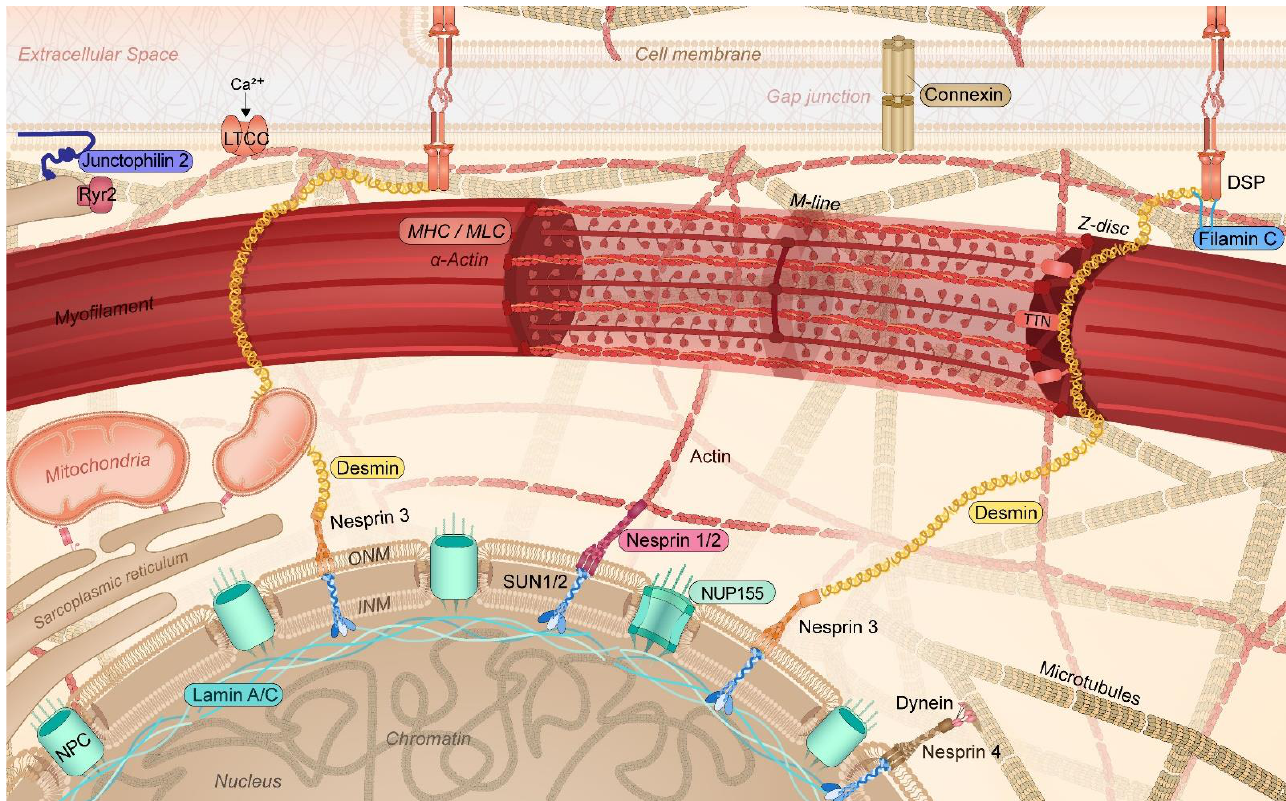
Figure 2. Schematic representation of the specific cytoskeletal protein complexes in cardiomyocytes linked to the onset of AF. Cytoskeletal (-associated) protein variants related to AF are highlighted (colored box). DSP: desmoplakin; INM: inner nuclear membrane; LTCC: L-type calcium channel; MHC: myosin heavy chain; MLC: myosin light chain; NPC: nuclear pore complex; NUP155: nucle- oporin 155; Ryr2: ryanodine receptor 2; TTN: titin; ONM: outer nuclear membrane; SUN1/2: Sad1p, UNC-84 domain-containing protein 1/2.